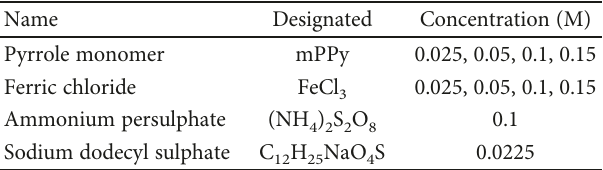
Table 1: All materials used and their concentrations. Name